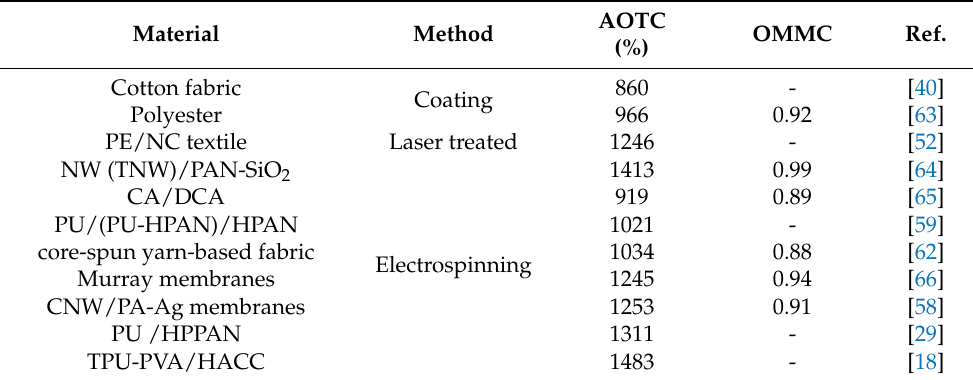
Table 1. Summary of DWT textiles for functional